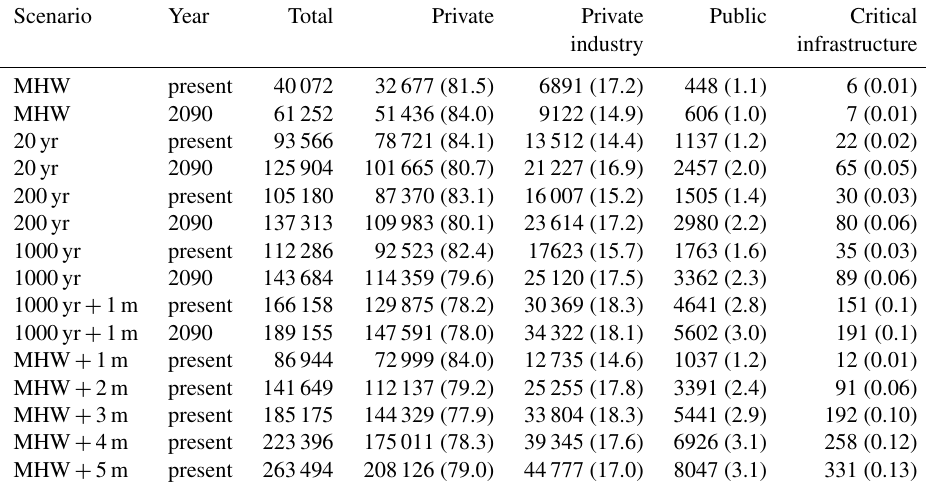
Table 3. Affected buildings in Norway under different water levels at present and for 2090. Numbers in parentheses indicate the percentage share of the total for each